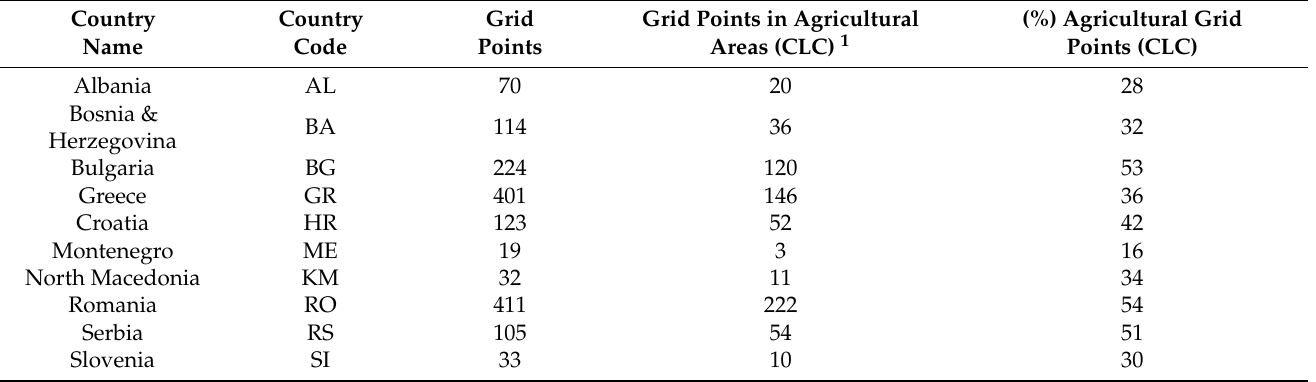
Table 2. Study area information about the total and agricultural area’s grid